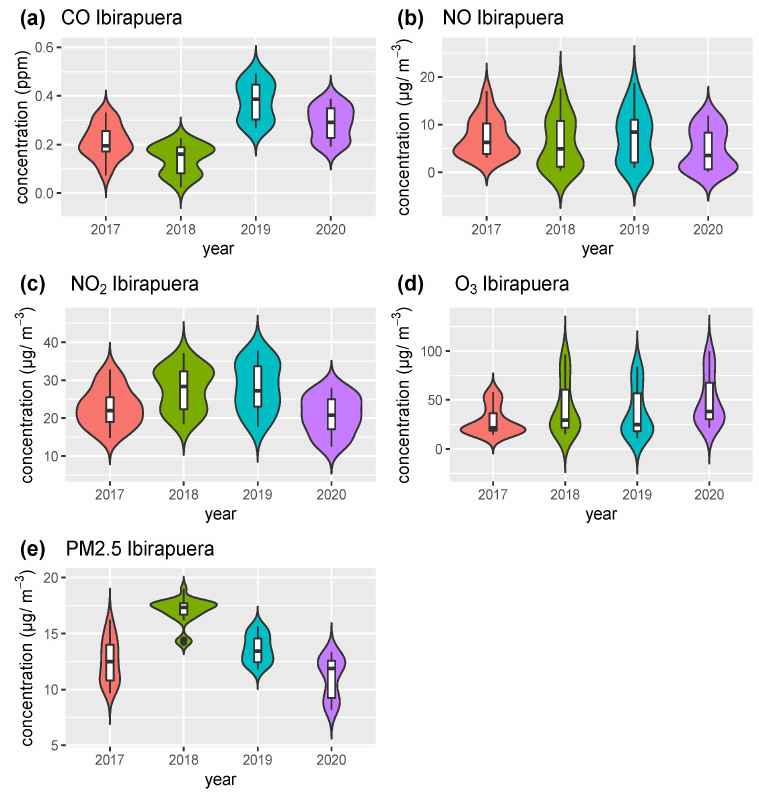
Figure 13. Violin graphs for Ibirapuera station during April to May 2017 to 2020 from ground AQMS.